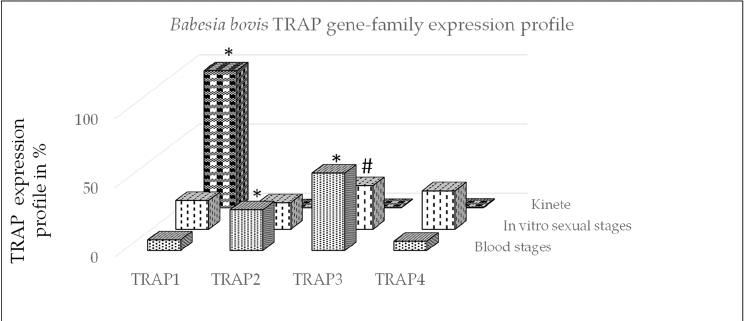
Figure 1. Babesia bovis gene-family expression profile using qPCR. The profile of TRAP genes was calculated for each stage by dividing each TRAP gene expression value by the total of TRAP transcripts and multiplied by 100 for a percentage and then summing the percentages within life stage per gene. *: significant within gene-family differences between stages ( p < 0.05) and #: non- significant difference between blood and sexual stages ( p = 0.06).